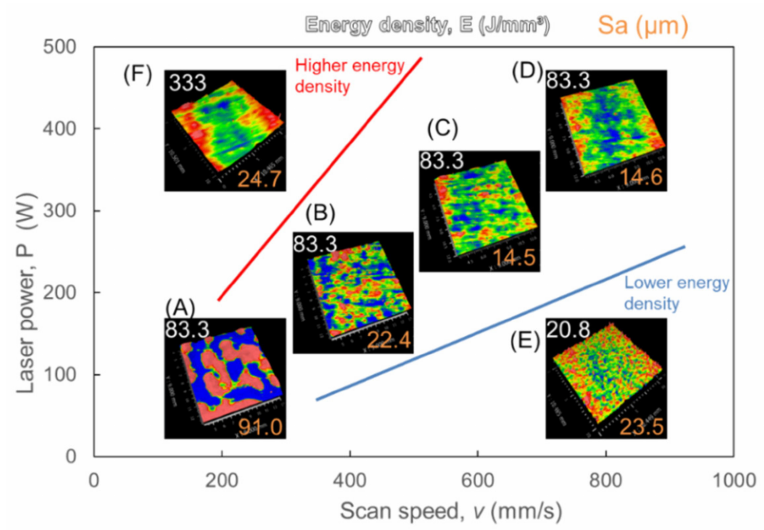
Figure 7. Surface-texture parameter ( S a )-based process map in terms of laser power and scan speed using the cubic specimens fabricated at various